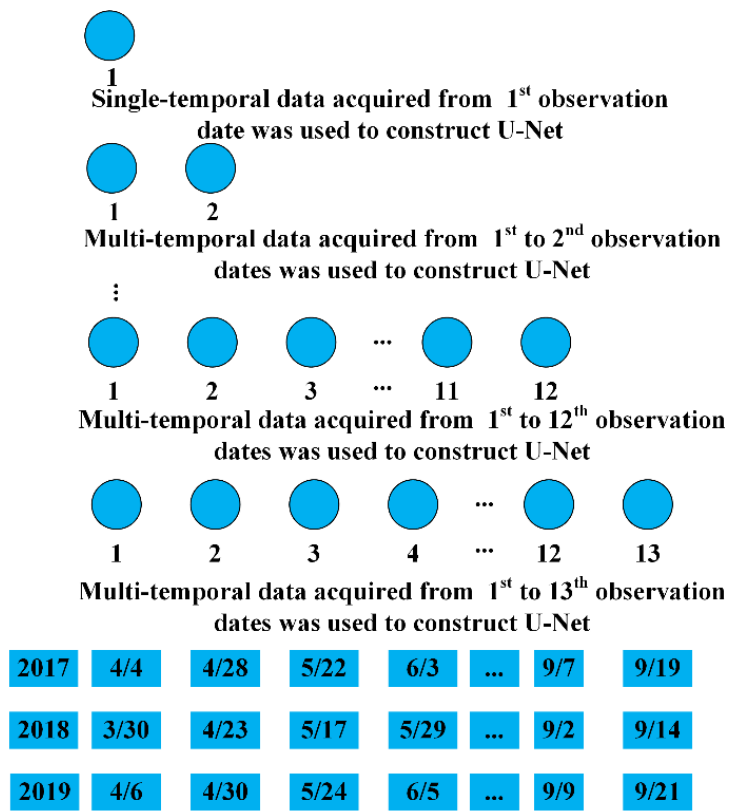
Figure 2. Based on the reference region, global search of optimal multi-temporal datasets for rice mapping. Take, as an example, the first observation date that was used as the start date; this process could also be used when other observation dates were used as the start dates.